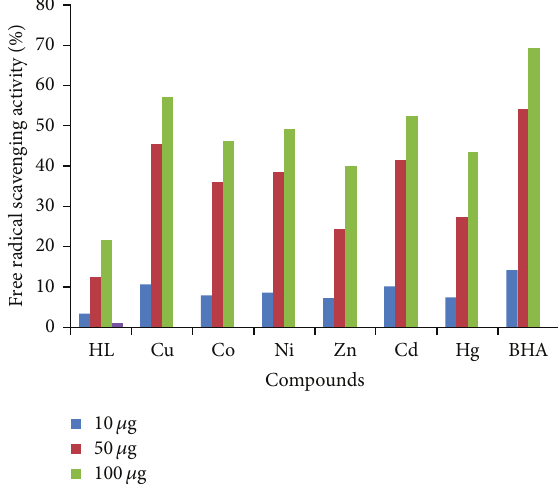
Figure 6: Antioxidant results of ligand and its complexes.